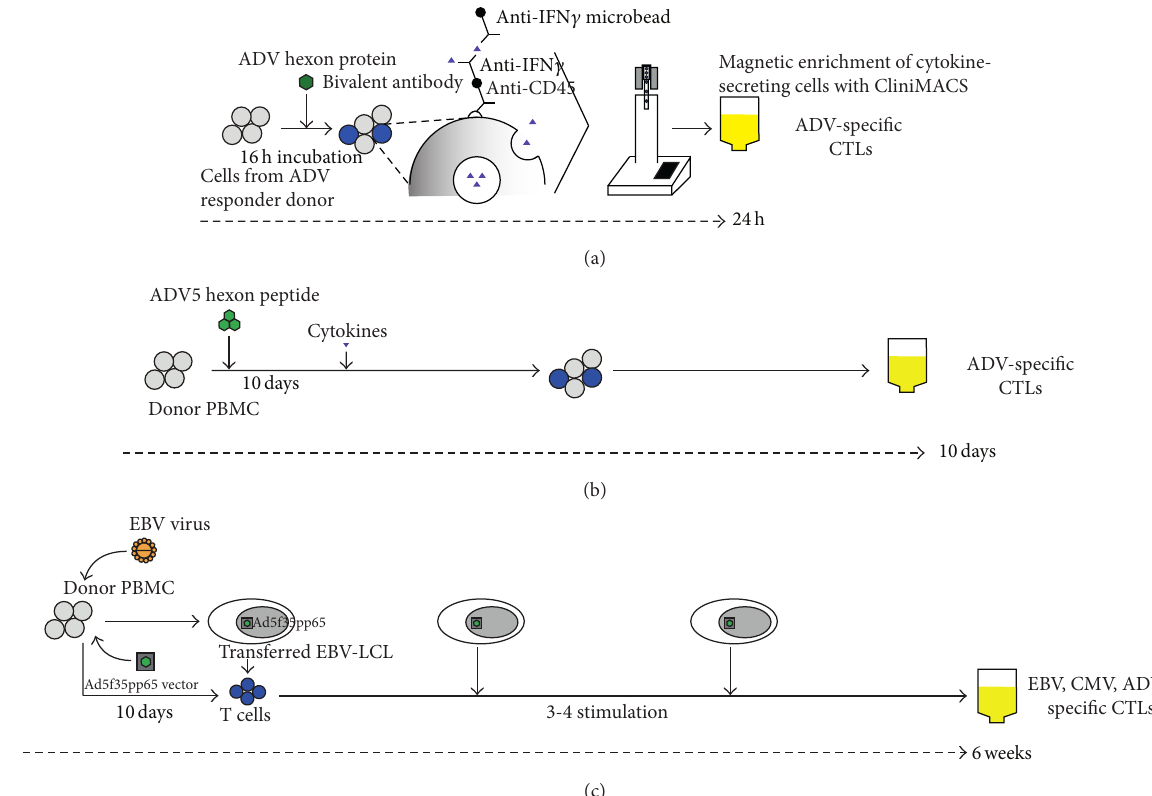
Figure 3: Protocols for generating virus-specific T cells. (a) Donor identified as ADV responder by IFN- 𝛾 secretion assay (Miltenyi Biotec, Bergisch Gladbach, Germany). Peripheral blood mononuclear cells (PBMC) isolated and incubated overnight with ADV Hexon protein. Responding cells captured with IFN- 𝛾 reagent, anti-IFN- 𝛾 microbead and magnetically enriched with CliniMACS (Miltenyi Biotec) [60]. (b) Donor PBMC incubated over 10 days with ADV5 hexon peptide and cytokines. Expanded cells isolated and infused into patients after QA/QC testing [61]. (c) EBV-transformed B cell lines (EBV-LCLs) generated from donor PBMCs by infecting with EBV virus. Donor PBMCs are transfected with Ad5f35pp65 vector (replication-competent adenovirus-negative) and later restimulated several times by EBV-LCLs that have been transduced with the same vector